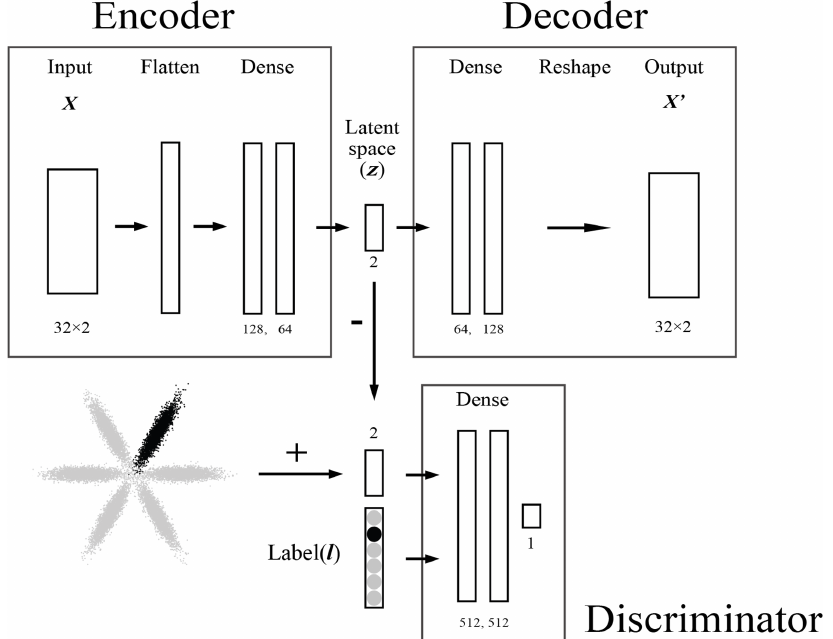
Figure 3. Semi-supervised adversarial autoencoder architecture with z representing the latent space and l as the label representing the one-hot vector. The unsupervised adversarial autoencoder will just consist of removing the input l